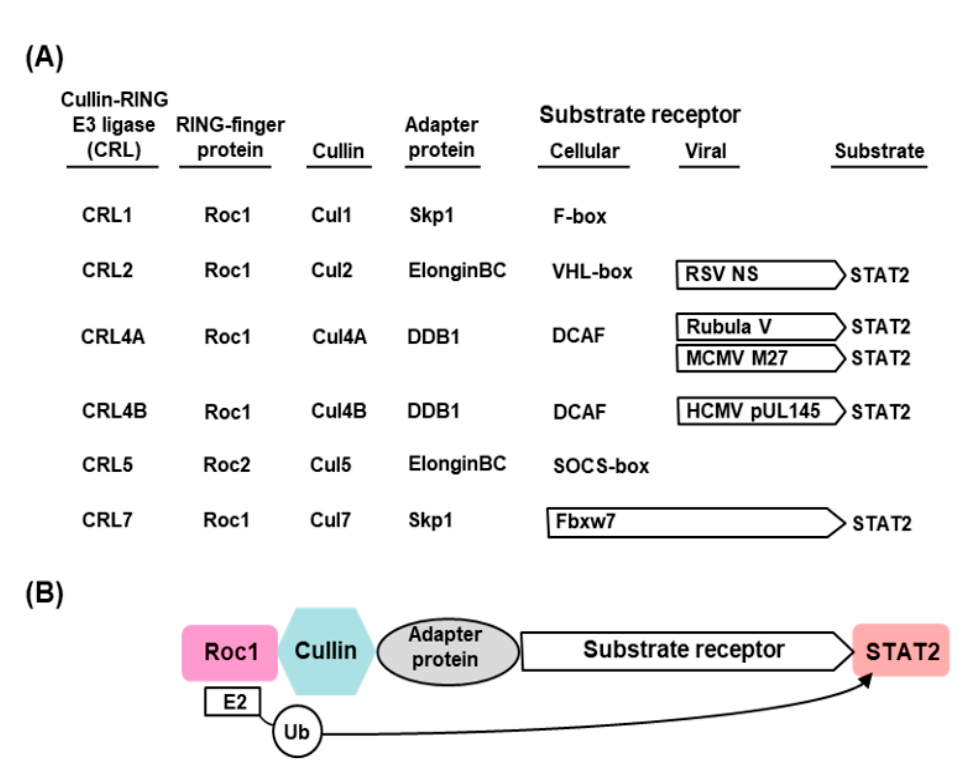
Figure 1. ( A ) Summary of different classes of Cullin–Roc E3 ligase (CRL) and representative viral proteins that exploit them for STAT2 degradation. ( B ) A general schematic of a CRL structure [59], presented in a linear fashion. In reality, this arrangement brings the Roc1-assciated E2 Ub-conjugating enzyme in close proximity to the substrate, resulting in the transfer of the Ub moiety from E2 to the substrate. Of the eight classes of CRLs (CRL1, 2, 3, 4A, 4B, 5, 7, and 9), only six that have been mentioned in this review are listed here. Each CRL is anchored by a distinct Cullin isoform and contains four core components: a Cullin (Cul) that acts as a scaffold, an E2 Ub-conjugation enzyme (Roc), a substrate receptor that recognizes the ubiquitination target, and an adaptor protein that links the substrate receptor to the Cullin. Only STAT2, which is the main focus of this article, is shown here as the substrate, along with the cognate CRLs that have been experimentally demonstrated to ubiquitylate it. The receptors that recognize STAT2 for ubiquitylation (and ultimate degradation by the proteasome) are marked with arrow-headed box. In the uninfected cell, cellular proteins (as listed) serve as receptors to ubiquitylate a variety of cellular proteins (not shown), whereas in the virus-infected cell specific viral proteins take their place.